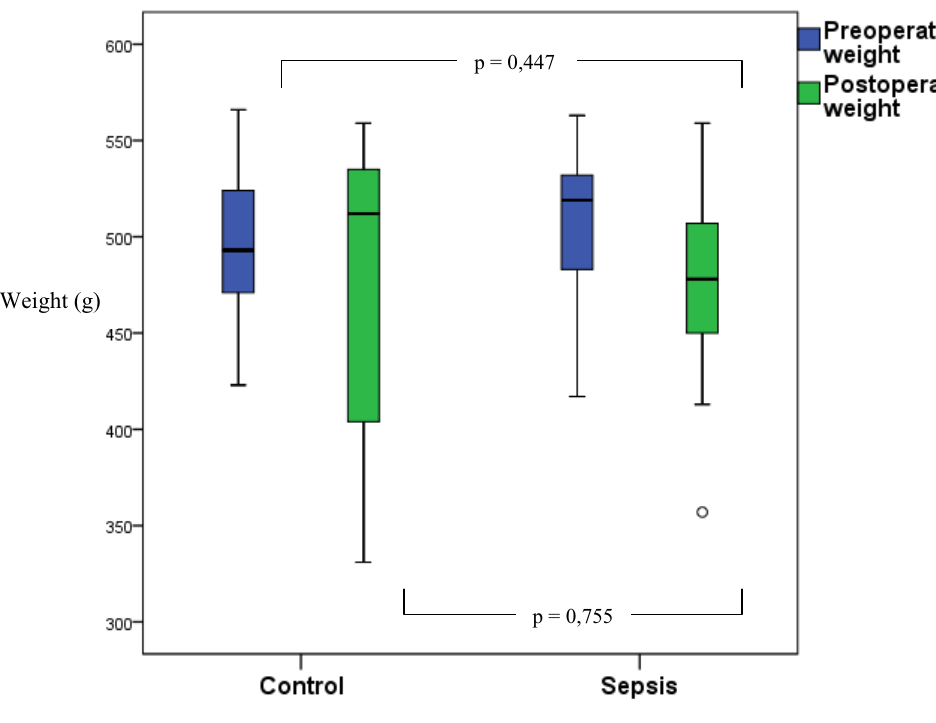
FIGURE 2 - Weight of animals euthanized on the 7 th postoperative